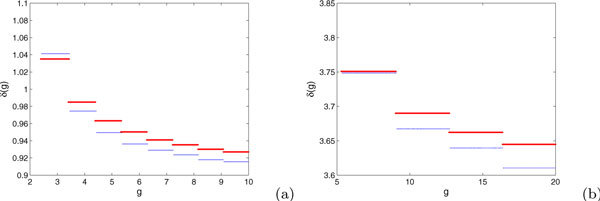
The red lines display the estimate of δ(g) for (2),(3) obtained by our calculations, while the blue lines show δ(g) from direct simulation for E = 1.2, I = 0.7, and (a) β = 0.5, G = 10 or (b) β = 2, G = 20.